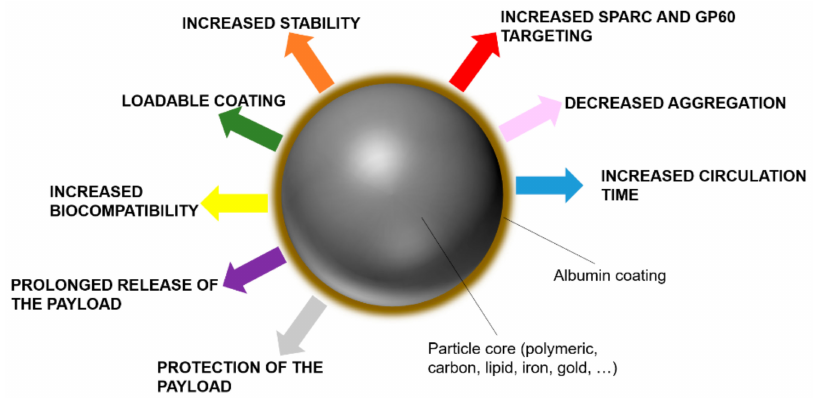
Figure 6. Benefits of albumin on the surface of